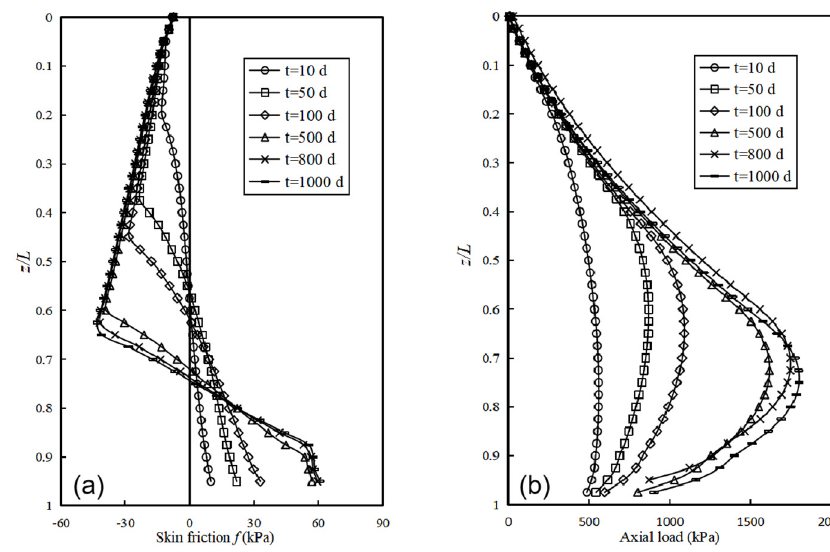
Figure 6. Effect of consolidation time on ( a ) skin friction and ( b ) axial load.